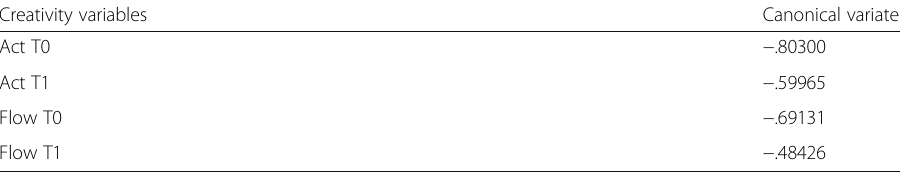
Table 5 Correlations between the raw creativity variables and their canonical variate Creativity variables